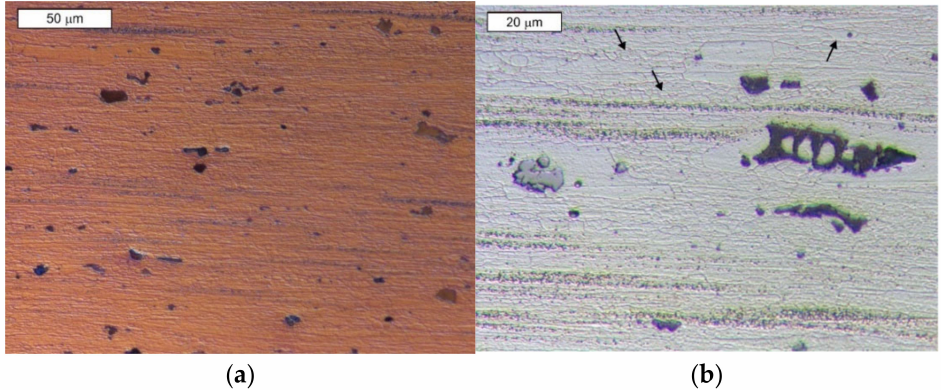
Figure 10. Magnified image of the alloy microstructure in the RRA state: ( a ) DIC contrast and ( b ) bright-field (BF). Etched state, light microscopy.